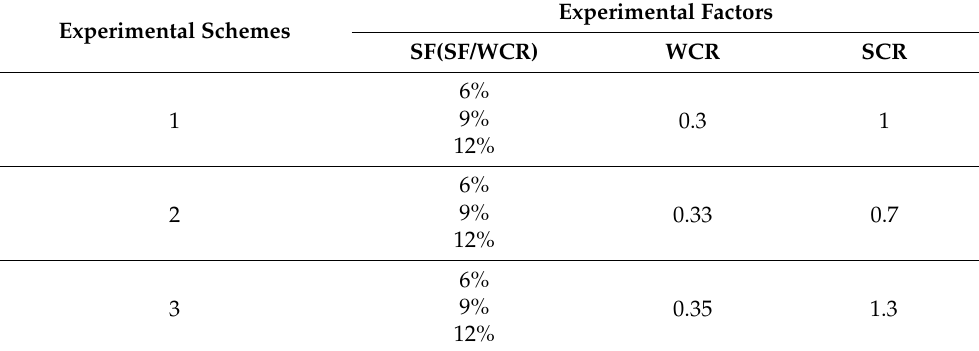
Table 4. Exerimental